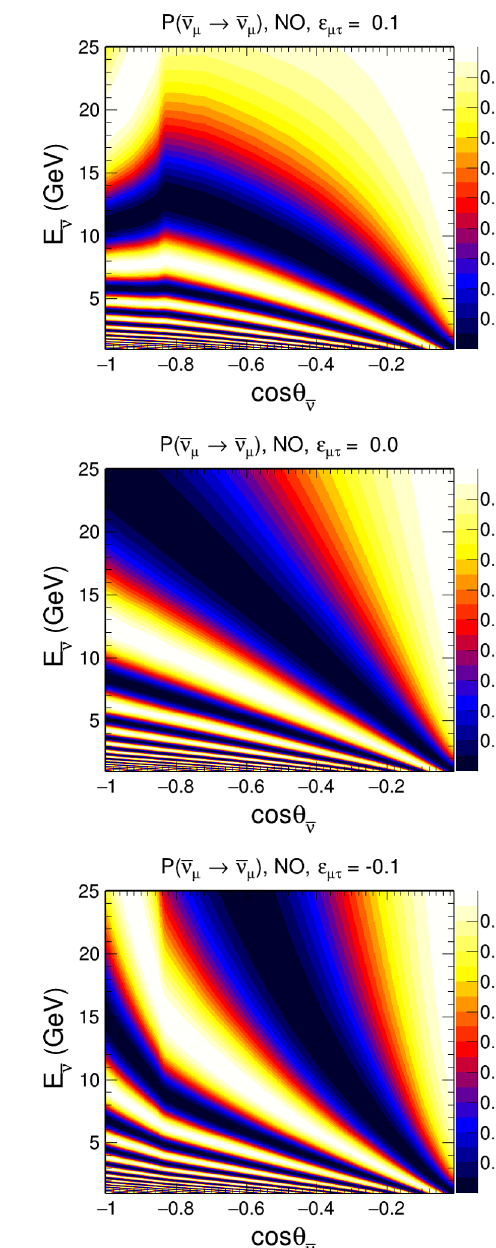
Figure 2 . The oscillogram for the survival probabilities in ( E ν , cos θ ν ) plane for neutrino and antineutrino in left and right panels, respectively, with normal mass ordering and the benchmark oscillation parameters from table 2. The value of ε is taken as +0.1, 0 (SI), and -0.1 in top, µτ middle and bottom panels,